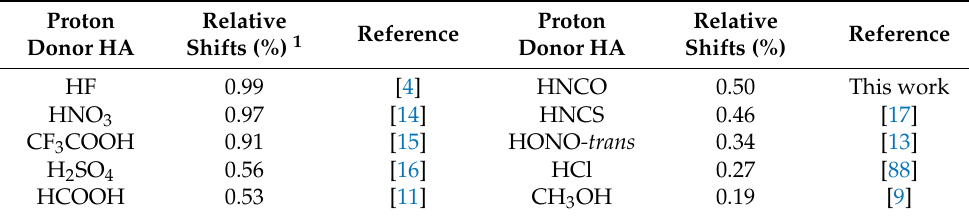
Table 8. The relative shifts observed for hydrogen bonded complexes of HA with nitrogen isolated in argon matrices. Proton Relative Proton Relative Reference Reference Donor HA Shifts (%) Donor HA Shifts (%) 1 HF 0.99 HNCO HNO 3